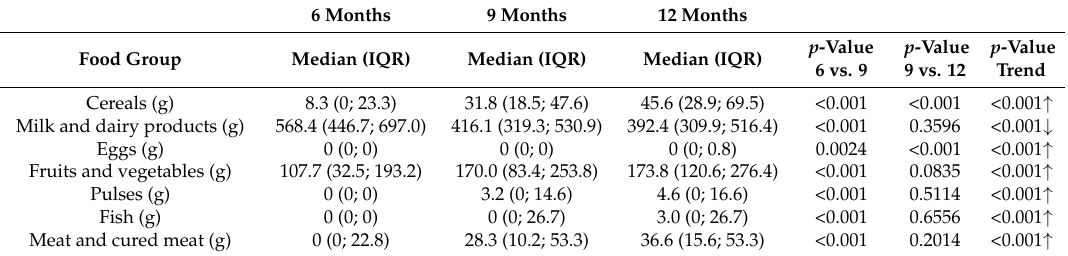
Table 3. Age-related trends in daily food group intake (g/day) between 6 and 12 months of age ( n = 152).